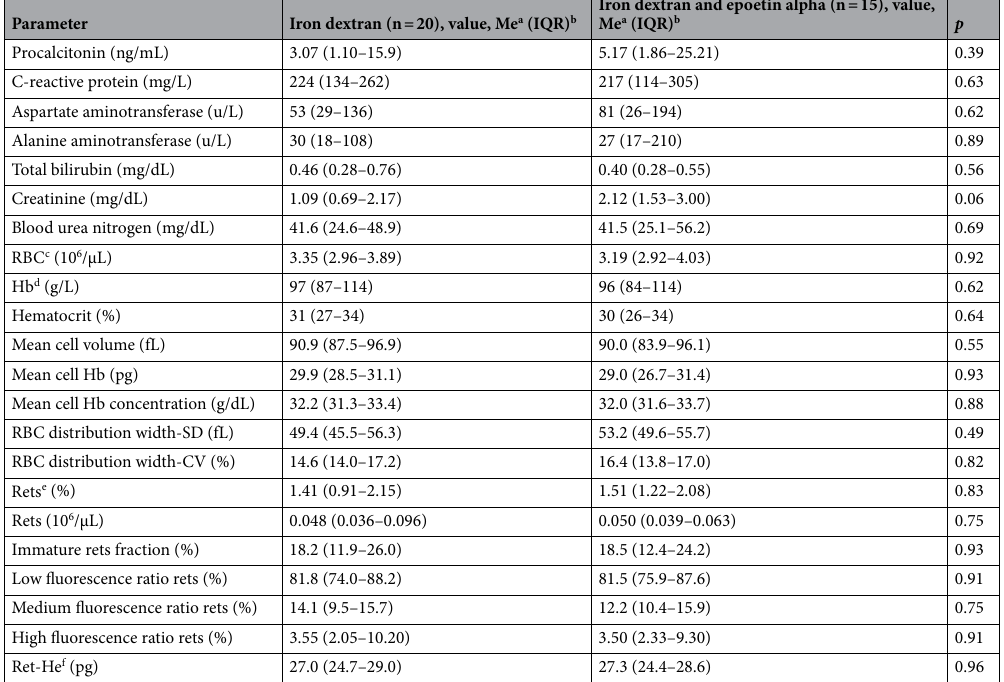
Table 3. Laboratory parameters of the study subjects divided into subgroups of patients receiving iron dextran or both iron dextran and epoetin alpha. a Median value. b Interquartile range. c Red blood cell. d Hemoglobin. e Reticulocytes. f Reticulocyte hemoglobin